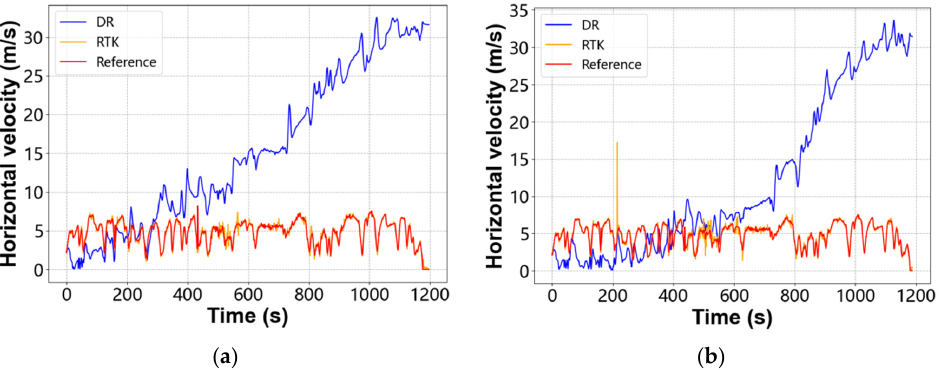
Figure 1. Horizontal velocity comparison. ( a ) Smartphone Huawei P30; ( b ) Smartphone Huawei